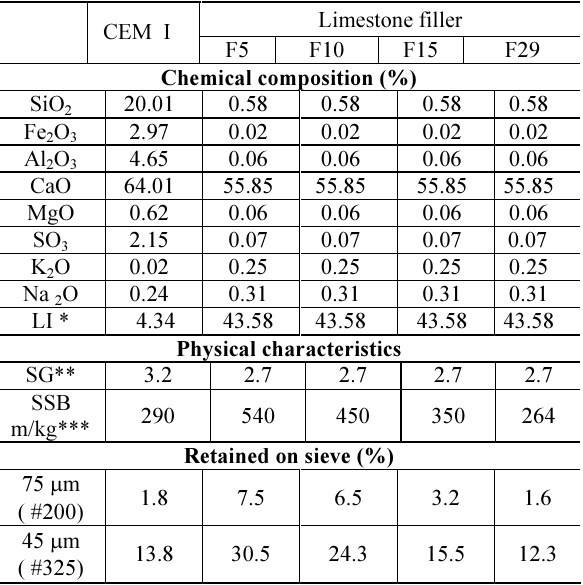
Table 2 . Chemical composition and physical characteristics of